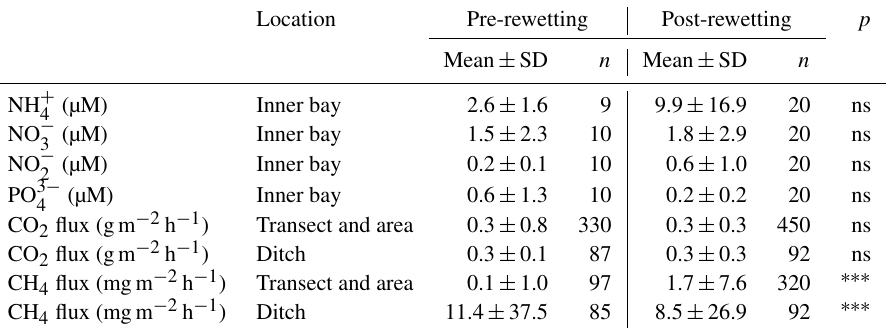
Table 3. Statistical comparison of pre- and post-rewetting nutrient concentrations and GHG fluxes. For pre- and post-rewetting phases, summer and autumn seasons were used (June to November 2019 and 2020, respectively). Nutrient concentrations are compared for the inner bay and GHG fluxes for the peatland site. The triple asterisks ∗∗∗ and ns indicate p < 0 . 001 and not significant,